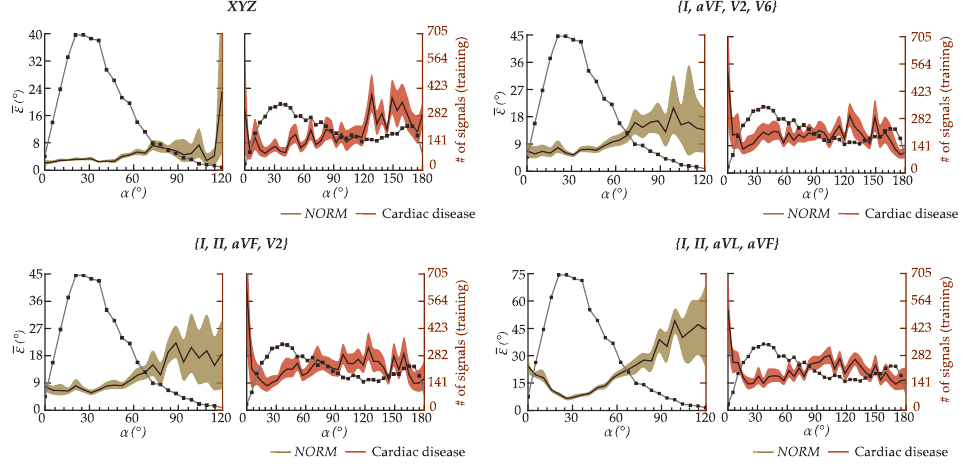
Figure 9. Variation of the mean absolute error (cid:101) and the respective the 95% confidence interval across the ranges of α =[0:5:180] ◦ for ECGs with normal ( NORM ) and diseased cardiac function. The right axis indicates the number of training samples in each range of α . Since the number of NORM subjects with α > 120° is almost negligible, (cid:101) is not shown for these ranges of α